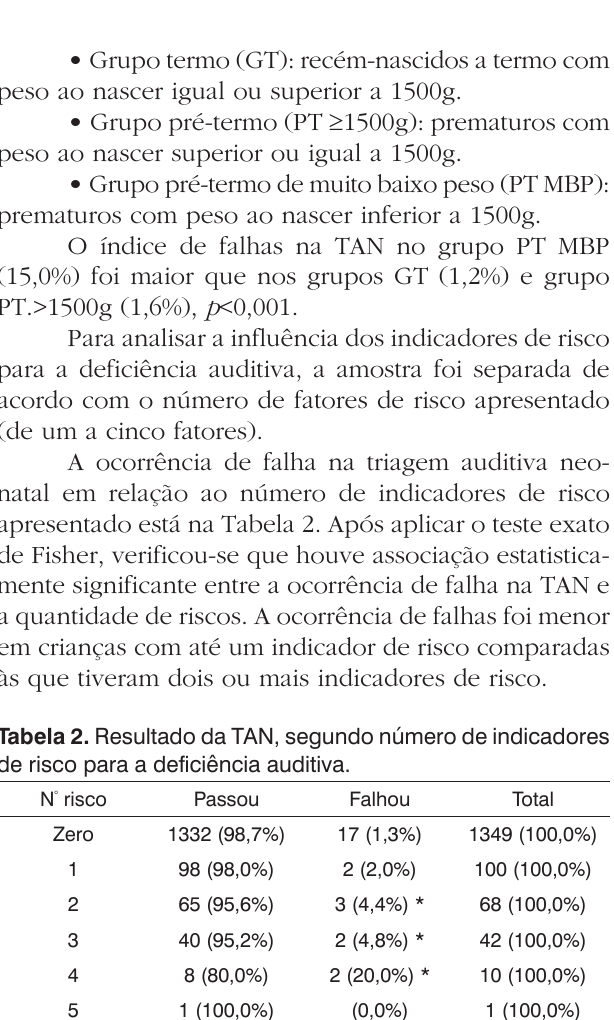
Tabela 4. Ocorrência de alterações auditivas em relação ao número de indicadores de risco apresentado.